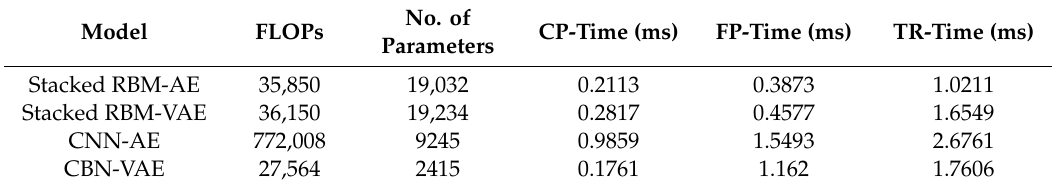
Table 4. Neural network model specific details comparison. [FLOPs] denotes the floating-point operations of the model compression and reconstruction. [CP-time] denotes the compression time. [FP-time] denotes the compression and reconstruction time. [TR-time] denotes the training iteration time. These results are obtained when the number of mini-batches is 1, and the time results are the corresponding unit